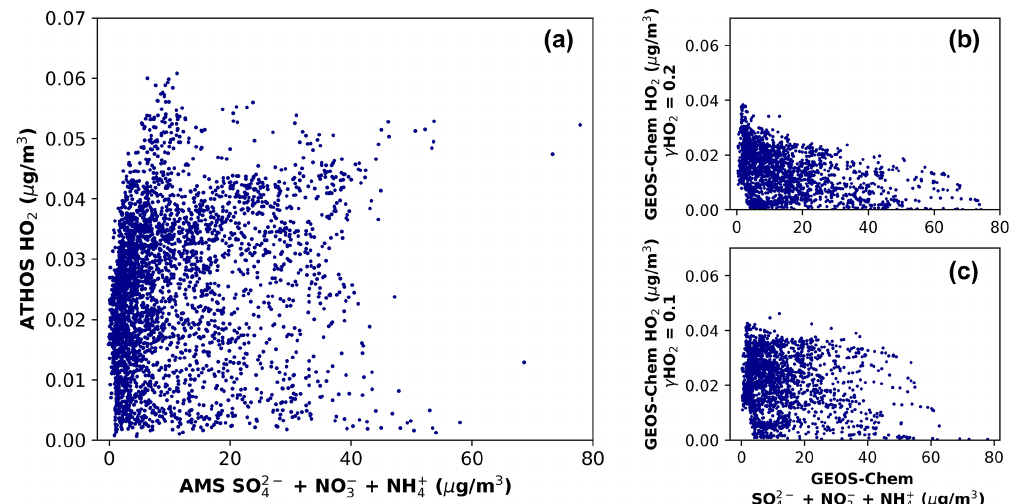
Figure 1. Relationship of HO 2 and sulfate–nitrate–ammonium (SNA) aerosol concentrations below 2km altitude during KORUS-AQ. Panel (a) shows the ensemble of observations from the ATHOS and AMS instruments. Panels (b) and (c) show GEOS-Chem model results with HO 2 reactive uptake coefficients ( γ HO ) of 0.2 (b) and 0.1 (c) . 2